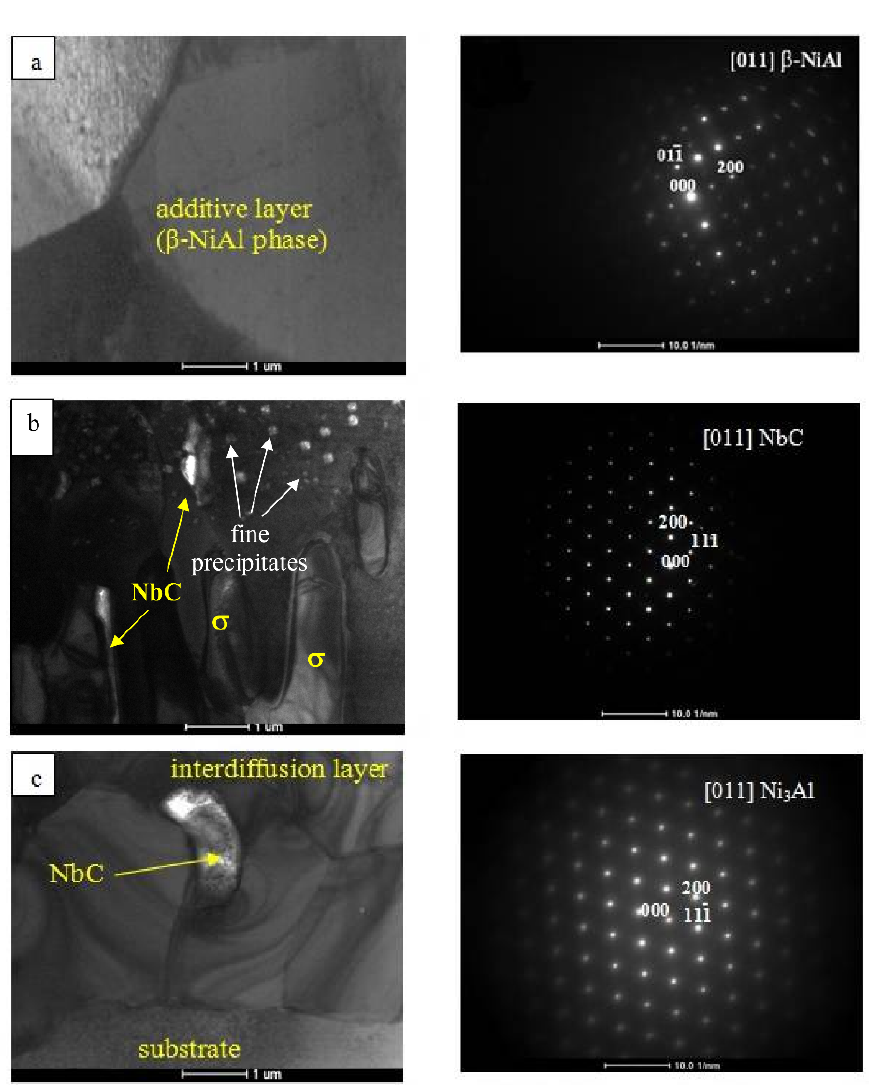
Figure 2. TEM images of the cross-section of the Hf and Pt modified aluminide coating: ( a ) the additive layer; ( b ) the interdiffusion layer; ( c ) the interdiffusion layer/substrate interface and accompanying electron diffraction patterns.